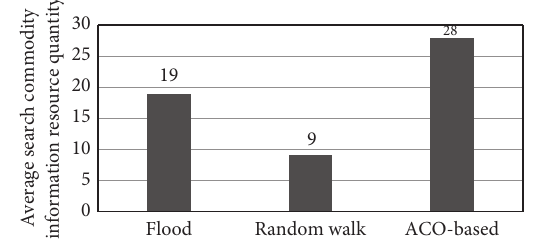
Fig. 4 Contrast map of average search commodity information resources.